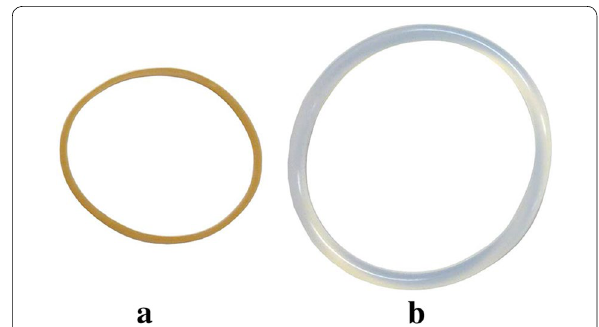
Fig. 7 Ring‑shaped objects used in experiments: a an elastic band (natural rubber) and b an o‑ring (silicon rubber)